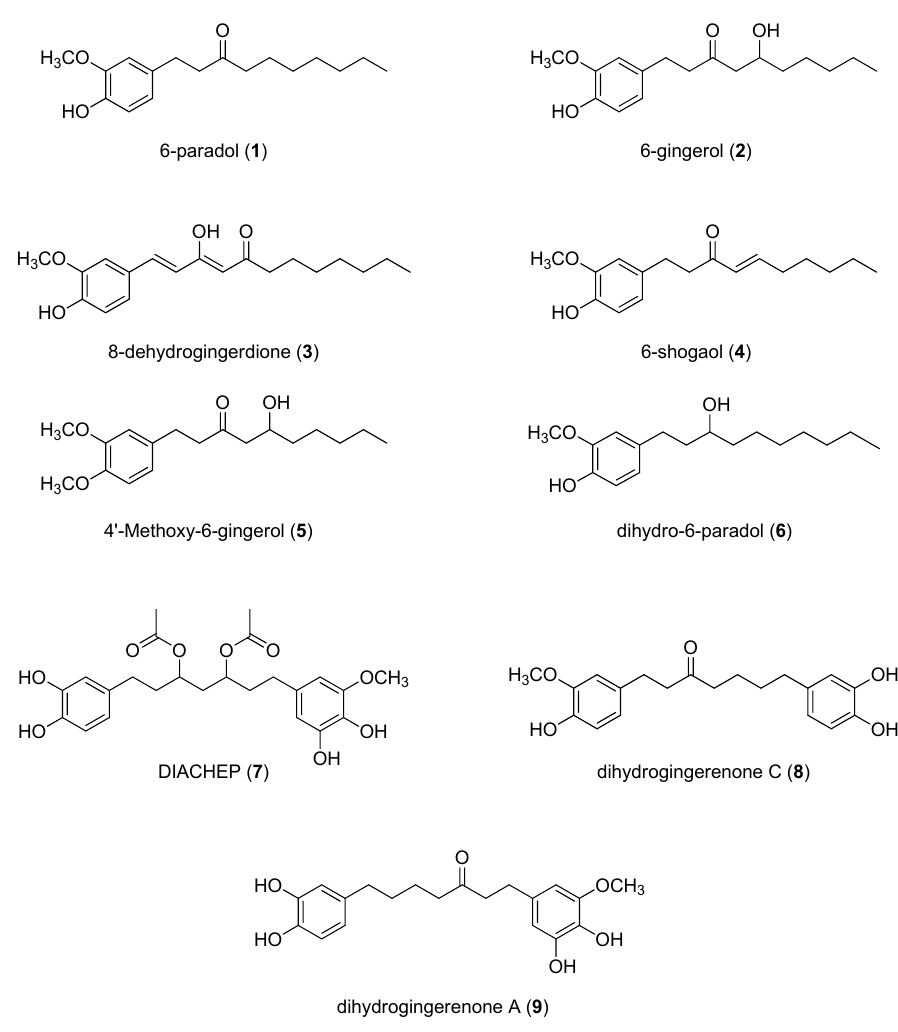
Figure 1. Compounds isolated from Aframomum melegueta .